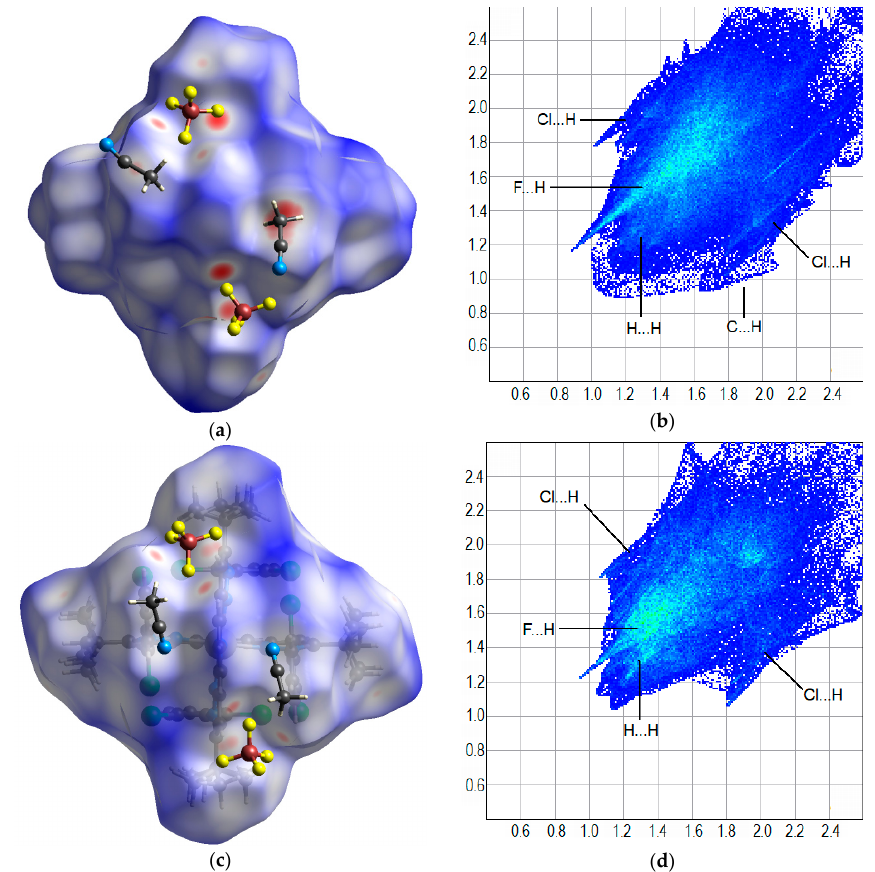
Figure 3. Hirshfeld surfaces of the cation [Fe( L ) 2 ] 2+ in [Fe( L ) 2 ](BF 4 ) 2 ·2CH 3 CN (red) ( a )